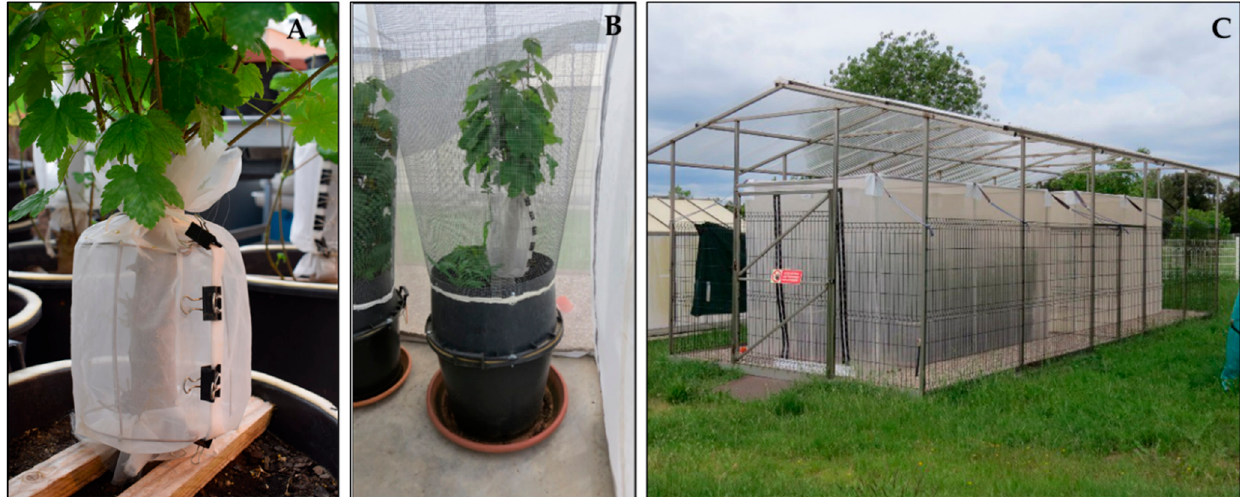
Figure 2. Exposure of A. fukutai adults to A. chinensis eggs on potted maple trees and rearing of the parasitoid under semi-natural conditions: ( A ) A. chinensis egg-infested tree exposed to parasitoid oviposition inside a sleeve cage, ( B ) potted tree with a hardware mesh cage to prevent the escape of adult A. chinensis , and ( C ) field test tent made of fine mesh in the certified outdoor quarantine enclosure at EBCL, protected by a plastic roof and metal fence.